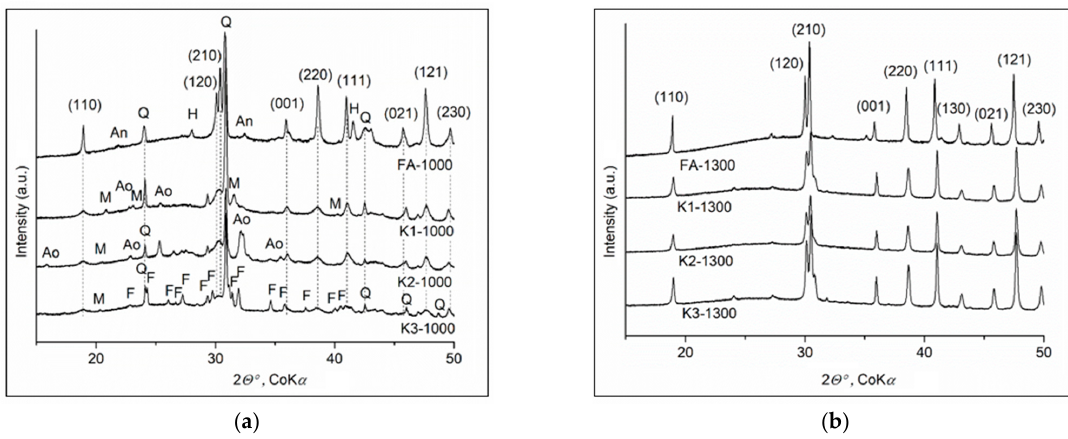
Figure 2. XRD patterns of kaolin samples K1, K2, K3 and FA annealed at temperatures: ( a ) 1000 °C and ( b ) 1300 °C. M— muscovite, Q—quartz, F—orthoclase, Ao—anorthoclase, An—anorthite, H—hematite, (hkl)—mullite. Table 3. Crystalline phases identified (+) and absent ( − ) in annealed FA and FA/K samples. Sample Mullite Quartz Anorthite Hematite Spinel Magnetite